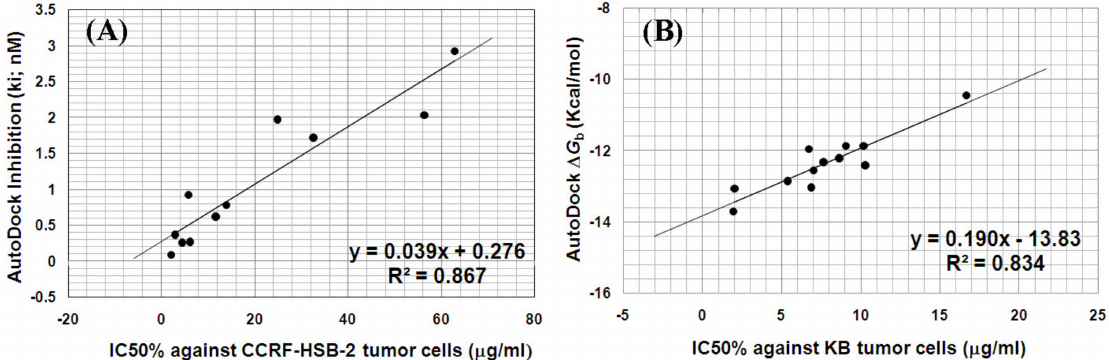
Figure 13. ( A ) Correlation between the IC 50 ( µ g / mL) against CCRF-HSB-2 tumor cell lines and AutoDock inhibition (Ki) for compounds 2b , 3d , 3i , 3j , 3m , 3k , 4a , 4c , 4d , 4e and 5a . ( B ) Correlation between the IC 50 ( µ g / mL) against KB tumor cell lines and AutoDock binding free energy ( ∆ G b )